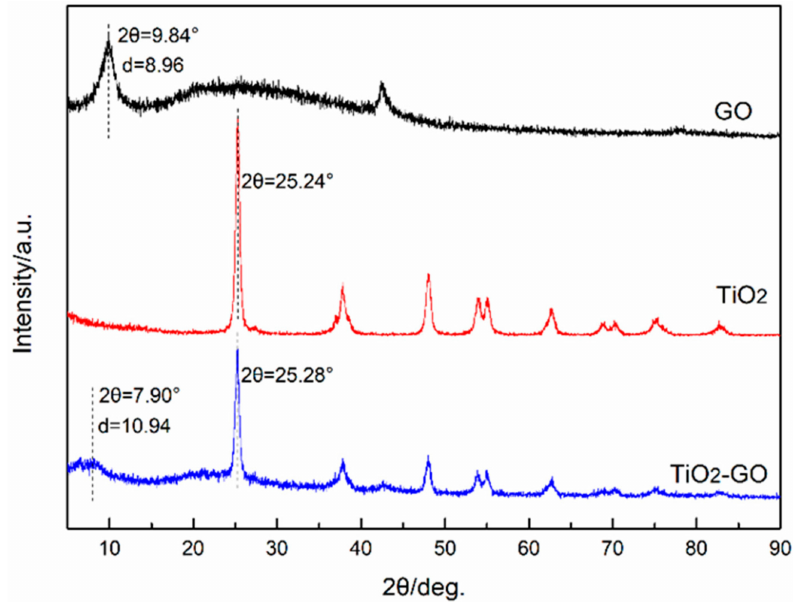
Figure 3. XRD patterns of GO, nano-TiO 2 , and TiO 2